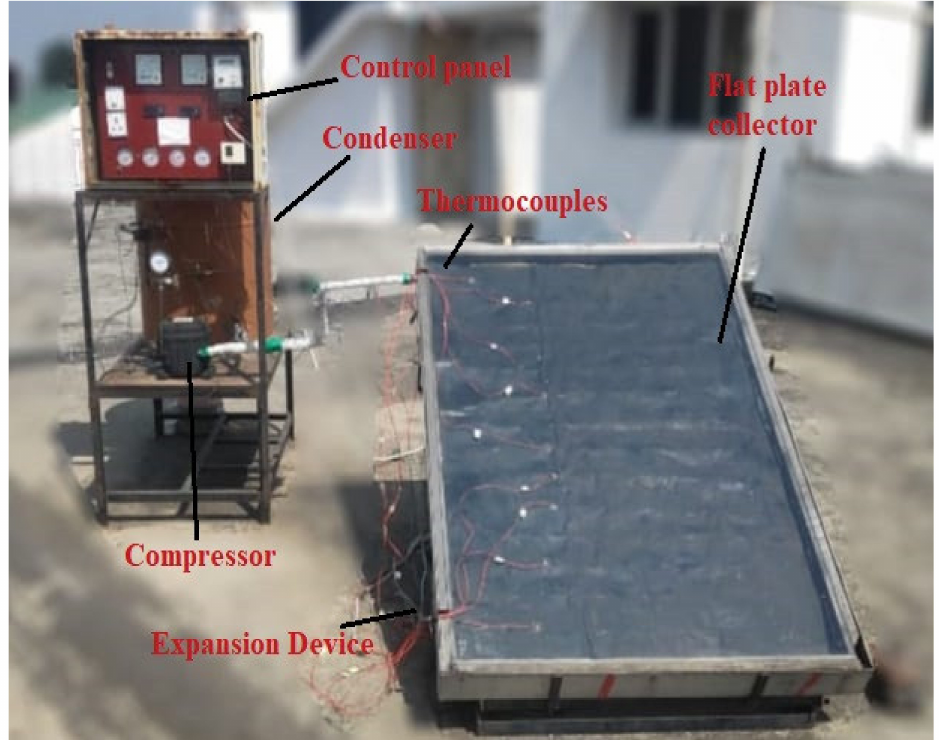
Figure 6. An illustration of the experimental